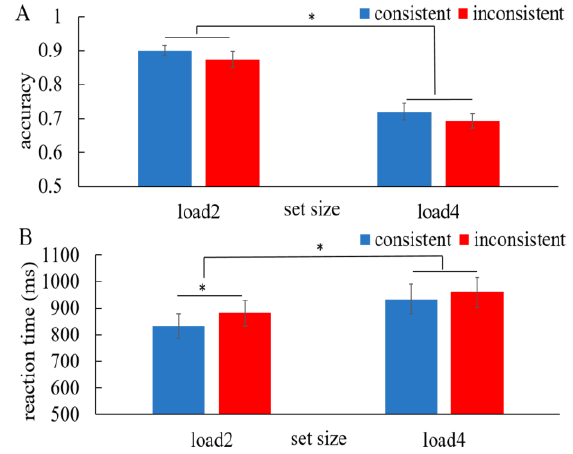
Figure 3. The performance of color WM in the WM + pur- suit session. (A) accuracy. (B) reaction time. Error bars repre- sent standard error. Asterisks indicate significance at p <